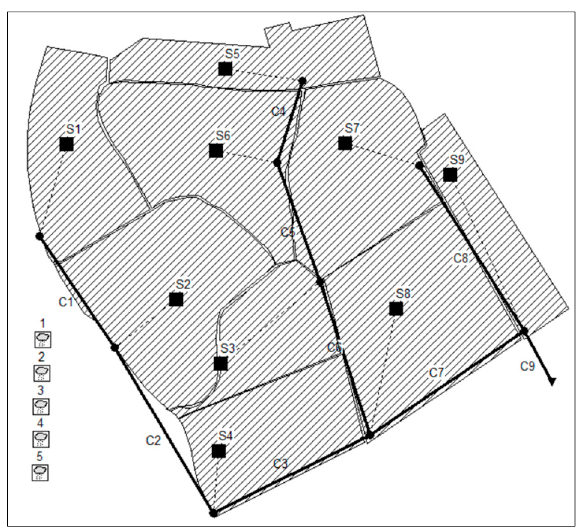
Figure 2. Generalized sketch map of sub-basin arrangement.